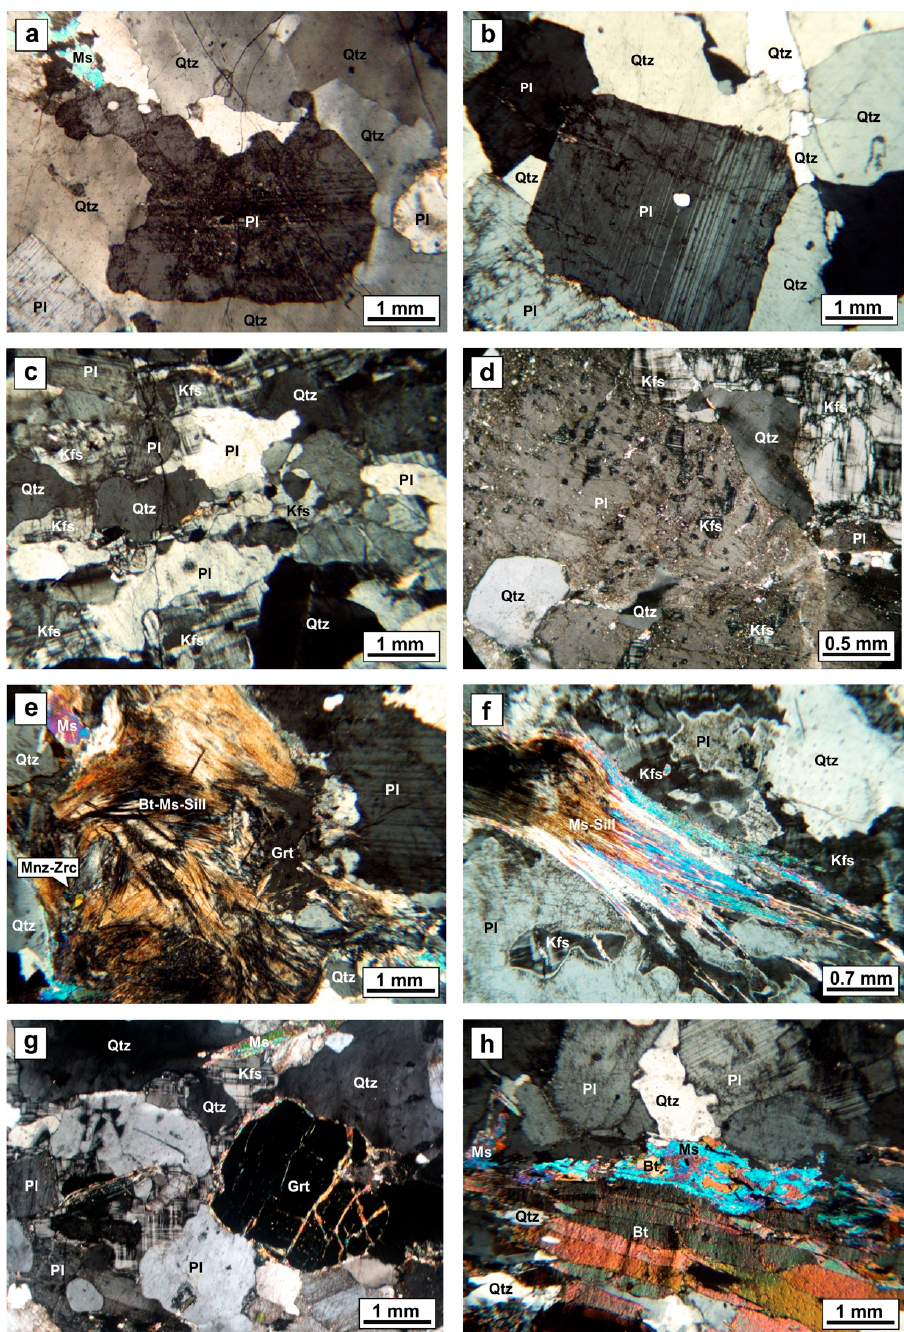
Figure 3. Photomicrographic details of studied migmatites (crossed polars). ( a , b ) Subhedral plagioclase surrounded by large quartz crystals in leucosome (samples PB17 and PB16, respectively); ( c ) granitic domain with allotriomorphic texture and tiny garnet in trondhjemitic leucosome (sample PB12a); ( d ) turbid secondary plagioclase replacing microcline in a granitic domain (sample PB14a); ( e ) accessory rich, biotite–sillimanite nodular pseudomorph after garnet (sample PB14a); ( f ) muscovite incongruent melting in a granitic domain (sample PB10); ( g ) garnet partly replaced by biotite and muscovite in a granitic domain (sample PB12a); ( h ) biotitic melanosome partly back-reacting to muscovite at the contact with the leucosome (sample PB14a).